Question: Write a descriptive caption for this figure.
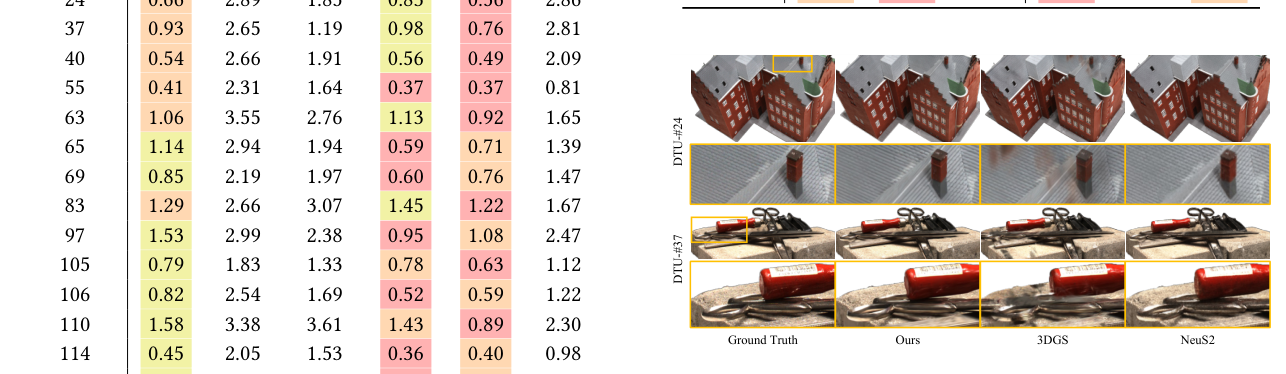
Answer: Rendering quality comparison under sparse inputs on DTU. With geometry constraints, our method and NeuS2 render floater-free images compared to 3DGS. Meanwhile our renderings recover better visual details than NeuS2’s.